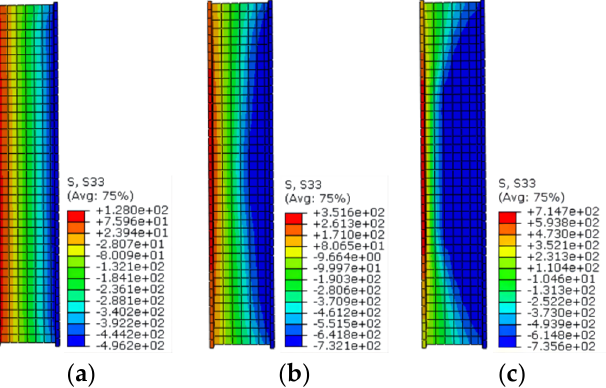
Figure 19. Longitudinal stress distribution of the H−shape steel at each stage for typical specimen HUCFEST−18: ( a ) elastic stage; ( b ) elastic−plastic stage; ( c ) plastic stage.